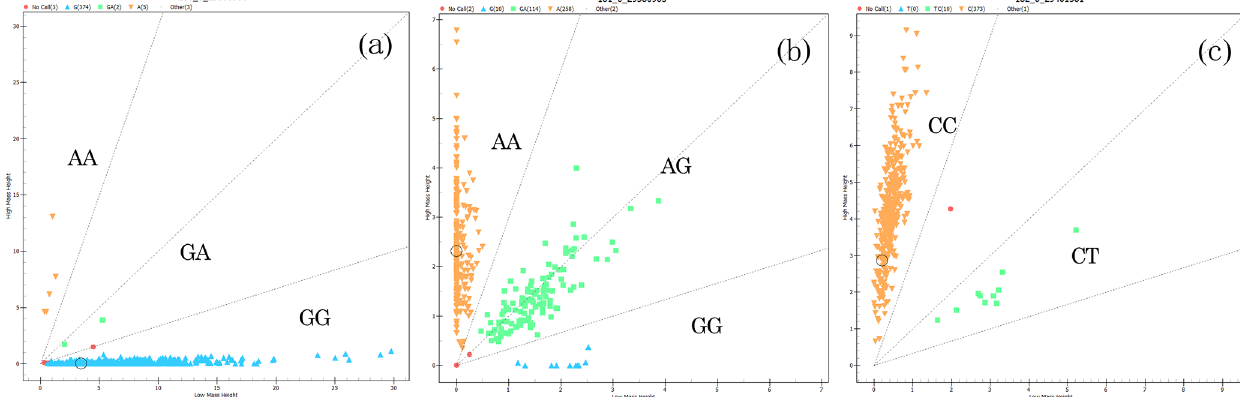
Figure 3. Genotyping in three loci of BMPR1B . The upper-left area indicates the AA genotype (a) with 5 individuals, the AA genotype (b) with 258 individuals, and the CC genotype (c) with 373 individuals; the middle area indicates the GA genotype (a) with 2 individuals, the AG genotype (b) with 114 individuals, and the CT genotype (c) with 10 individuals; the lower-right area indicates the GG genotype (a) with 374 individuals and the GG genotype (b) with 10